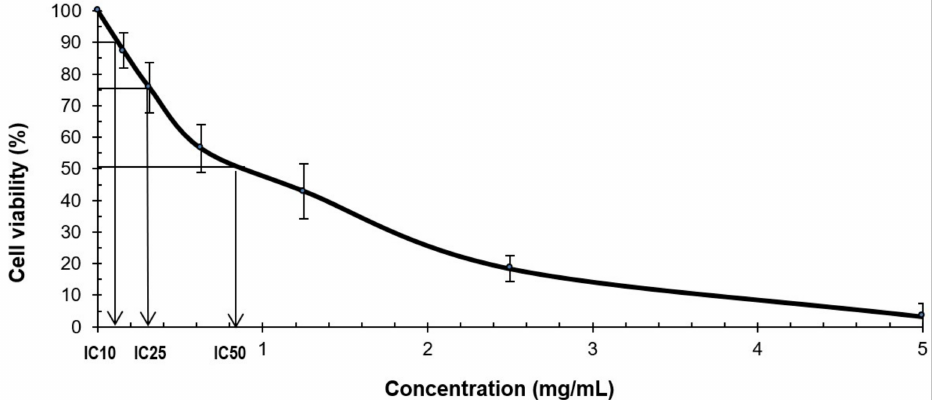
Figure 2. Cytotoxic effect of FDAE was demonstrated following 24 ± 2 h treatment on V79B cells. Data are expressed as percentage of viability compared to negative control (without any